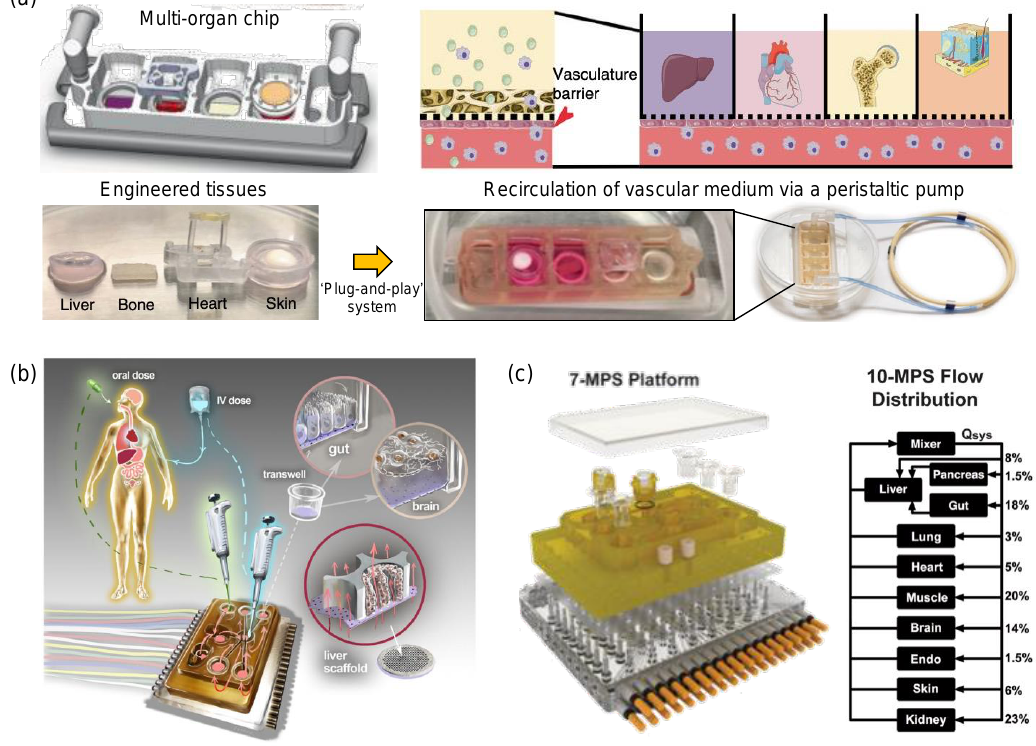
Figure 9. Modeling multi-organ systems on a chip. ( a ) The integrated multi-organ chip connects the liver, bone, heart, and skin along the vascular flow with the concept of a plug-and-play system to maintain tissue-specific niche. Figure reproduced from Ronaldson-Bouchard, K. et al., 2022 [104]. ( b ) Schematic diagram of a multi-organ on-chip system [106]. ( c ) Design and construction of multi- organ partitions within the microphysiological system platform. Multi-organ flow distribution design through the arrangement of major components such as channels, pumps, and reservoirs. Figure reproduced from Edington et al., 2018 [106].